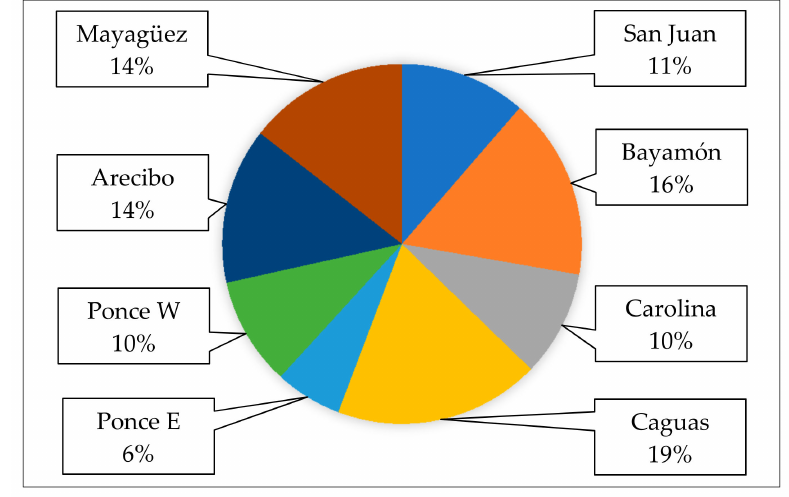
Figure 6. Available residential rooftop area by region in Puerto Rico in 2017.